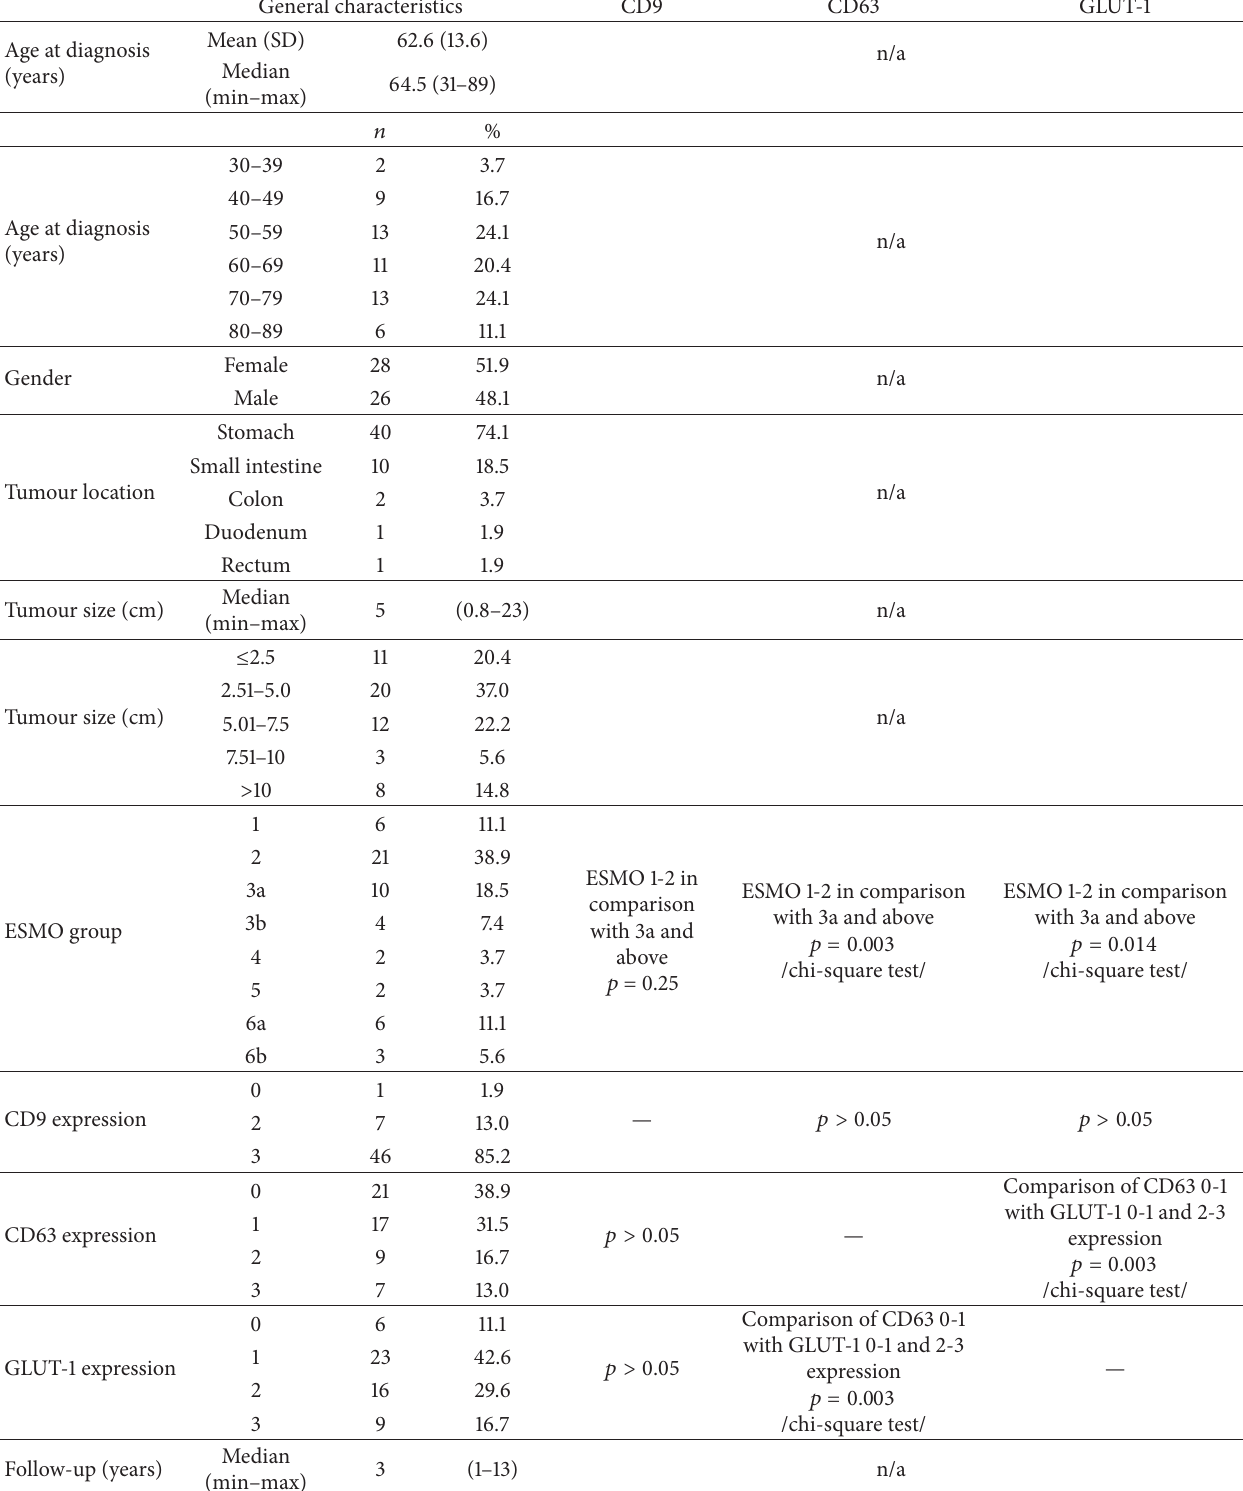
Table 1: Characteristics of patients and